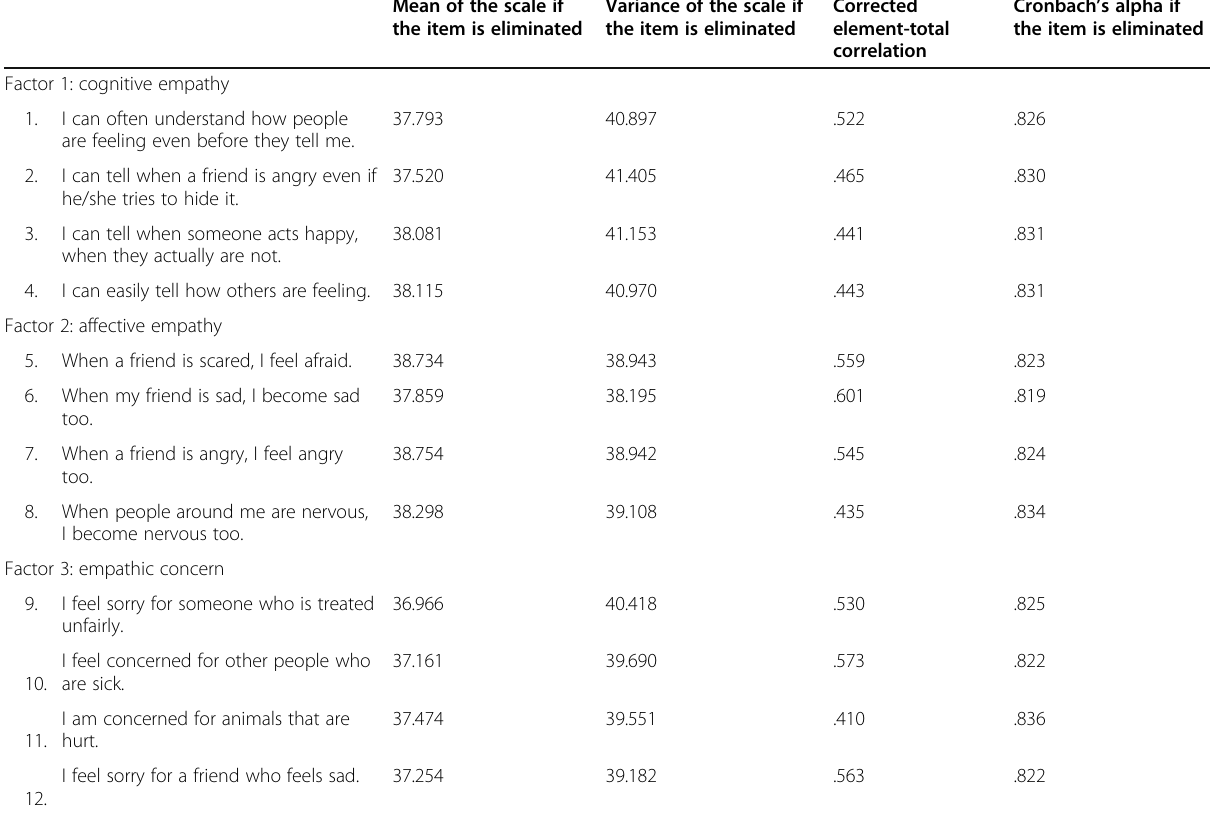
Mean of the scale if Variance of the scale if the item is eliminated the item is eliminated